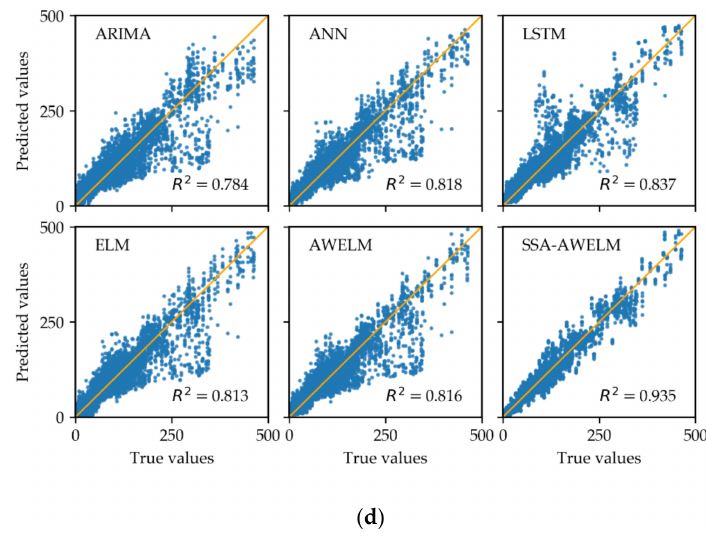
Figure 8. Prediction results: ( a ) exit passenger flow of the Q. R. Sta., ( b ) entrance passenger flow of the Q.R. Sta., ( c ) exit passenger flow of the J. Sta., and ( d ) entrance passenger flow of the J. Sta.